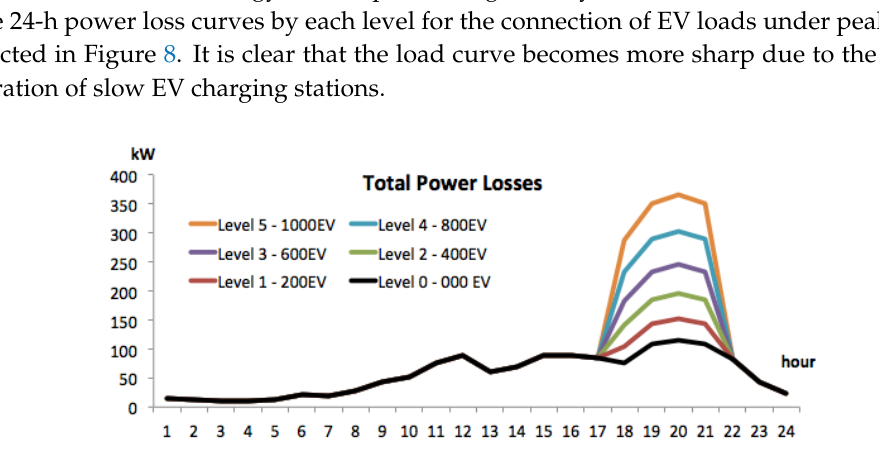
Figure 8. Peak load scenario: 24-h power losses by EV penetration